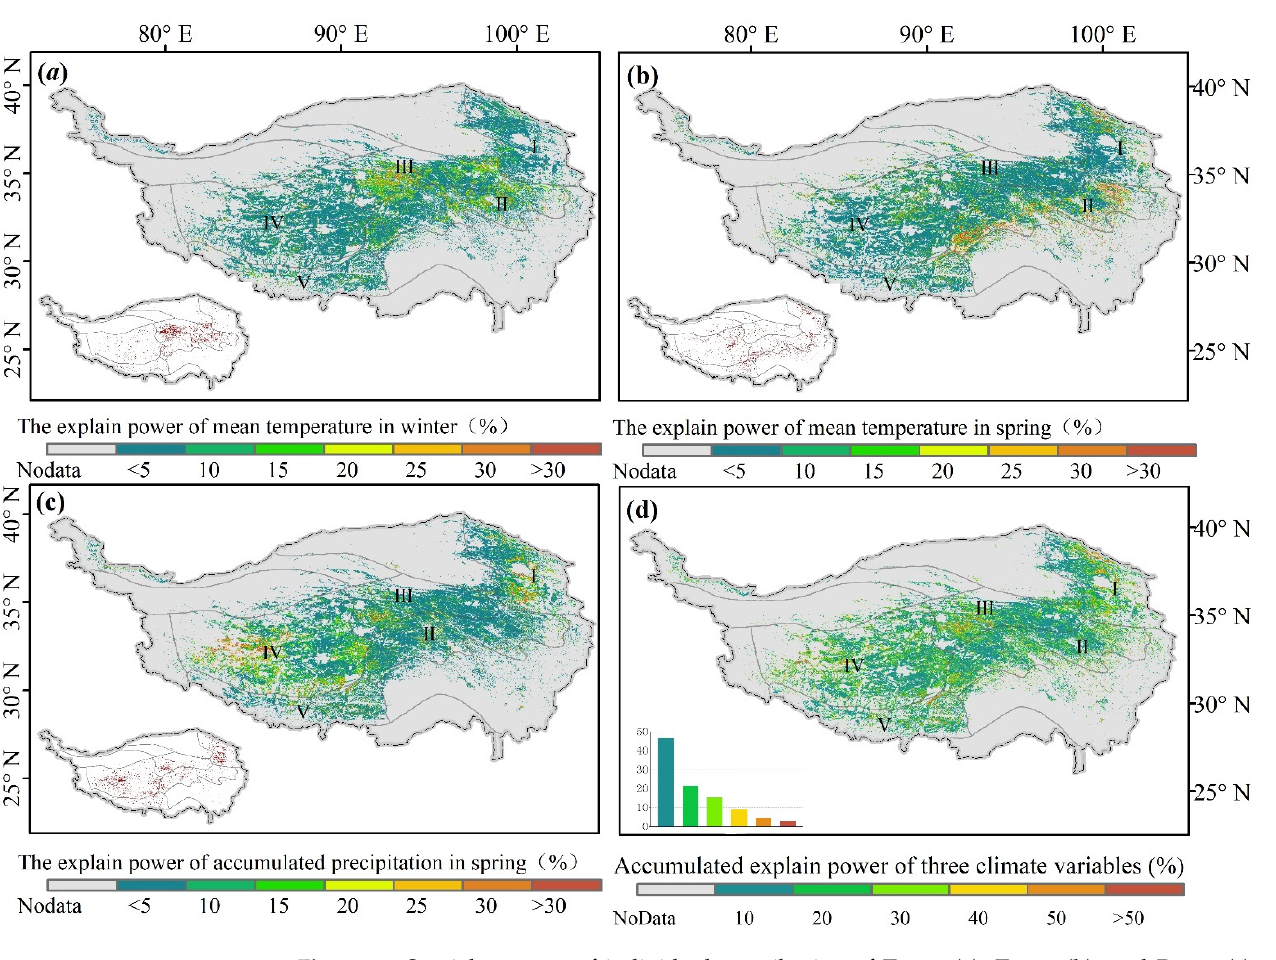
Figure 4. Spatial patterns of individual contribution of T winter ( a ), T spring ( b ), and P spring ( c ) to interannual variation in SOS and cumulative contribution of all factors ( d ). Inset in ( a – c ) shows spatial distribution of pixels with significant trend ( p < 0.05), and inset in ( d ) shows proportion of corresponding accumulated contribution indicated by map legend. I, II, III, IV, and V indicate different ecoregions following Figure 1.